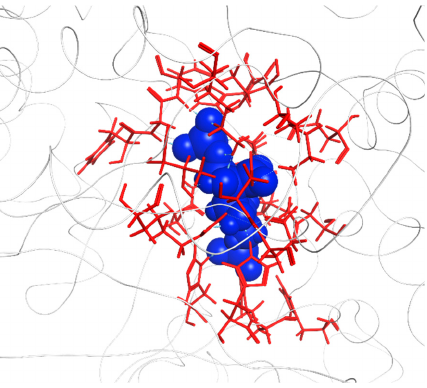
Figure 9. Residues around the active site (PDB entry: 1UWA, FMODB entry: 53J5Z), where the 2CABP ligand is shown by blue spheres. Red sticks represent 22 residues used for clustering (A- chain: Thr173, Lys175, Lys177, KCX201, Asp203, Glu204, His294, Arg295, His298, His327, Lys334, Leu335, Ser379, Gly380, Gly381, Phe402, Gly403, and Gly404; O-chain: Glu60, Thr65, Trp66, and Asn123). KCX, a lysine residue modified by carbamylation.